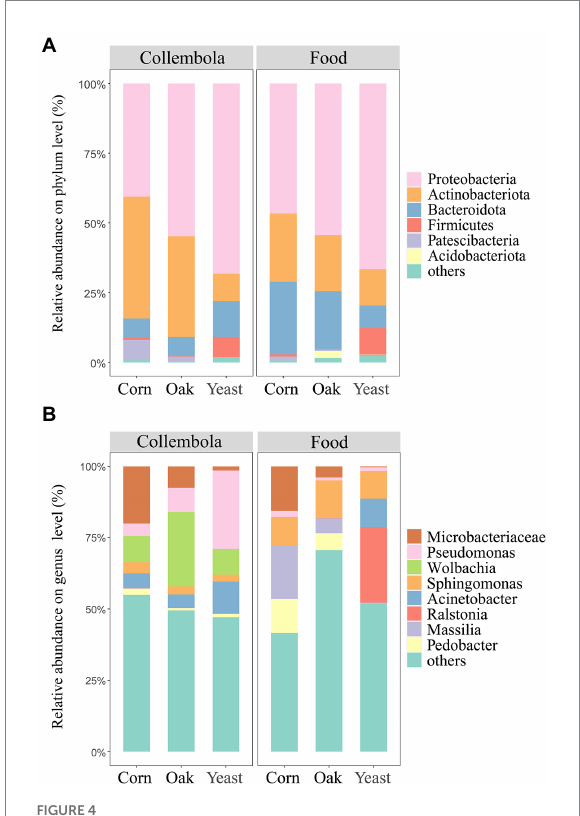
FIGURE 4 Bacterial community composition in cold-adapted Collembola and food. Panel (A) shows the bacterial community composition of Collembola at phylum level. Bacterial phyla with relative abundance <1% were categorized into ‘others’. Panel (B) shows the bacterial community composition of Collembola at the genus level. Bacterial genera with relative abundance <10% were categorized into